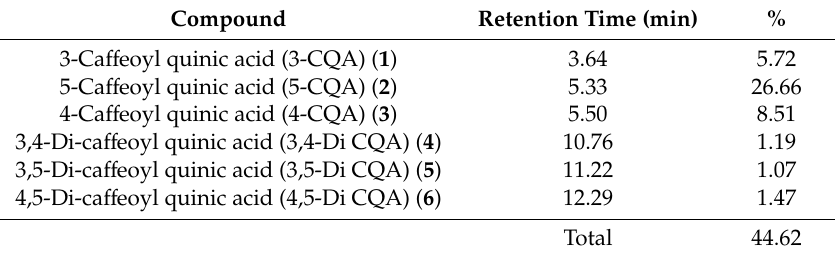
Table 1. Chlorogenic acids content of sunflower extract expressed as 5-CQA equivalent